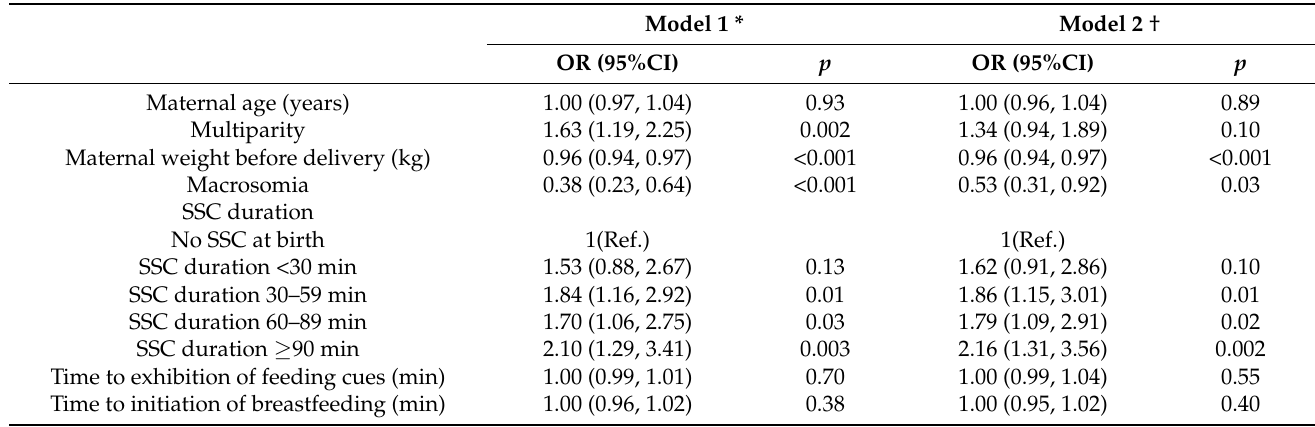
Table 3. Promoting factors for exclusive breastfeeding at hospital discharge.